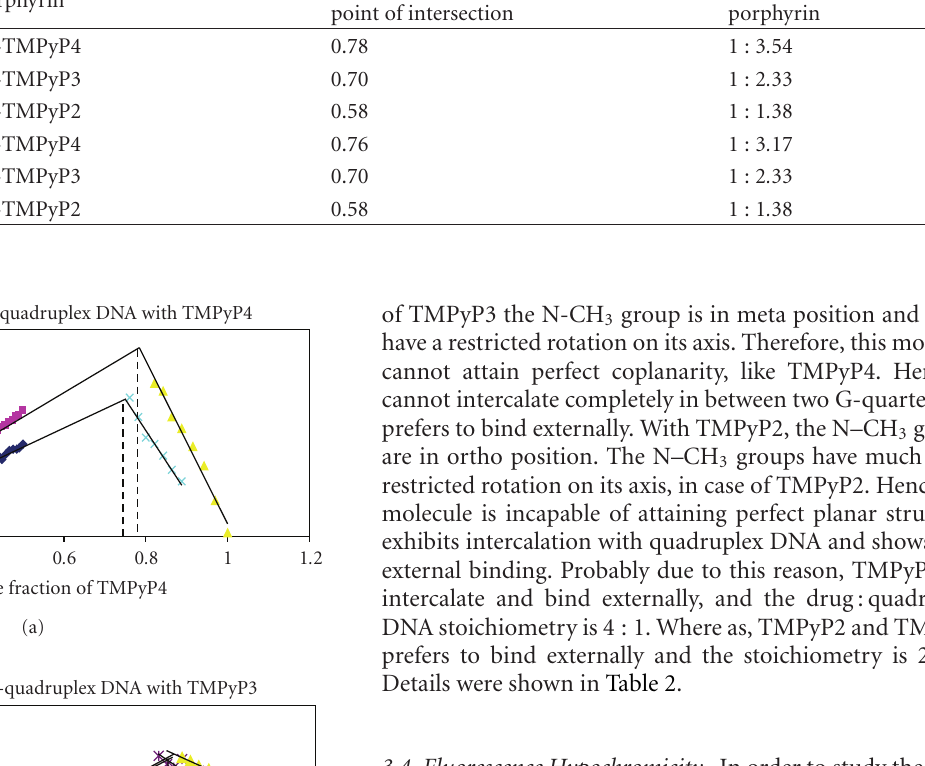
Table 2: Data obtained from Job plot of Bcl2 and C-myc G-quadruplex DNA with TMPyP4, TMPyP3, and TMPyP2 porphyrin drugs. S. No.